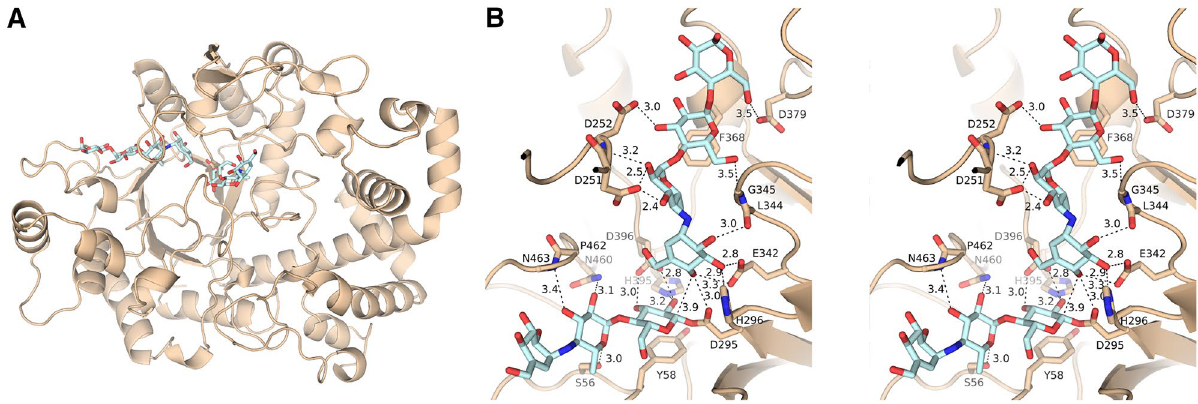
Figure 2. ( A ) Crystal structure of Sa AM (wheat) with acarbose and the acarbose-derived glycosyl-enzyme intermediate (cyan). ( B ) Stereo images of the Sa AM active site. Interactions are shown in dash lines with distances in angstrom